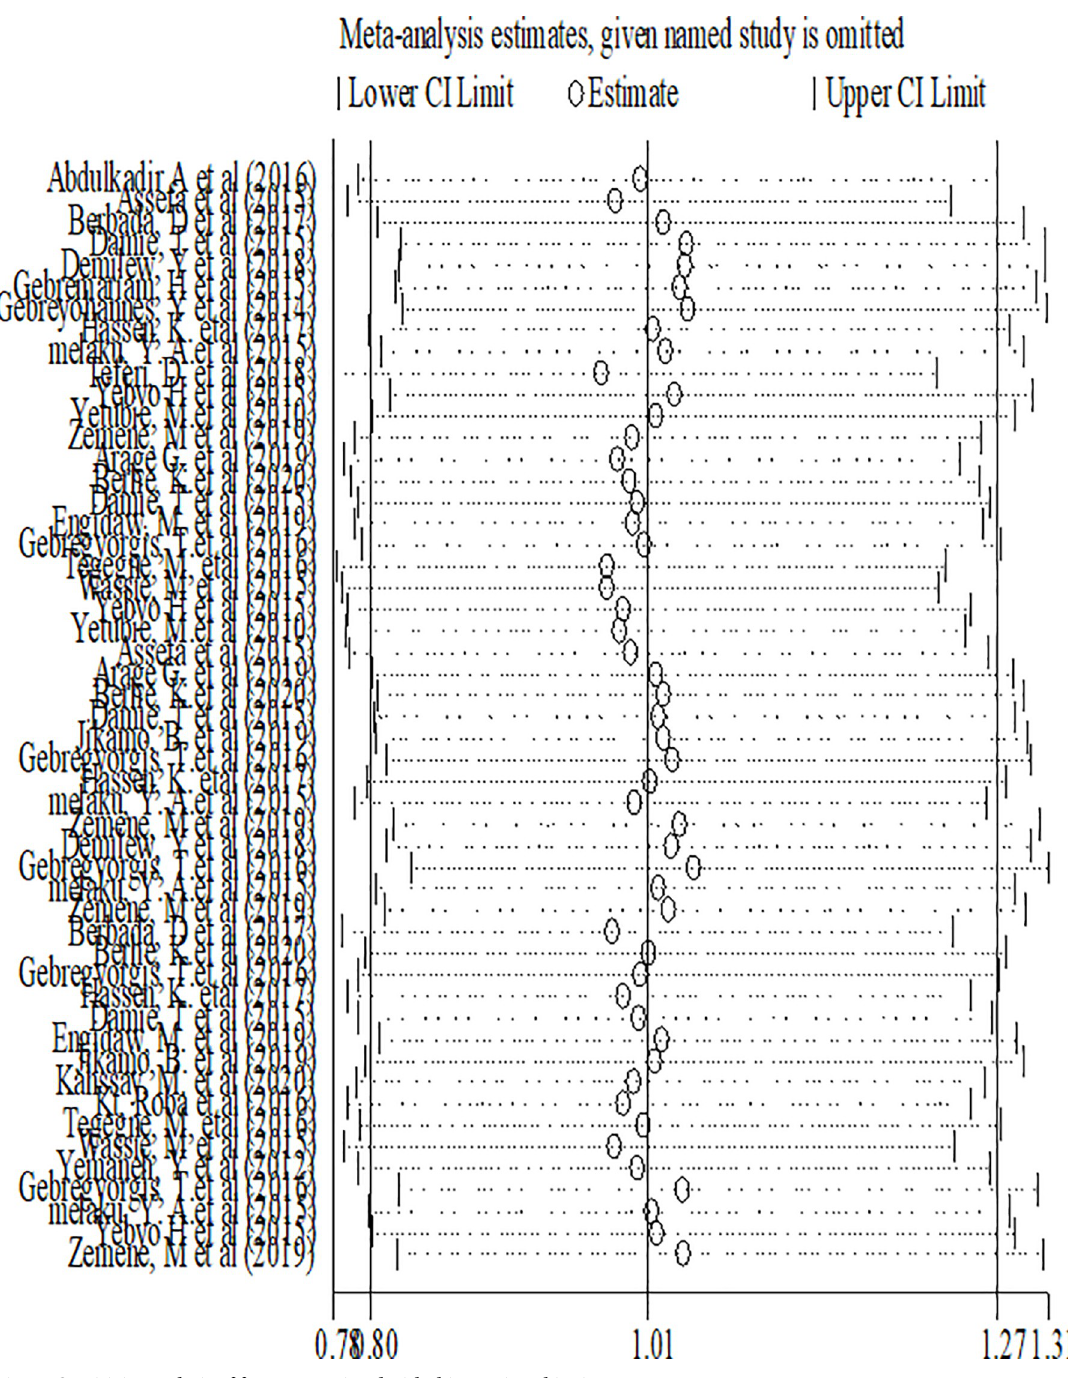
Fig 18. Sensitivity analysis of factors associated with thinness in Ethiopia.